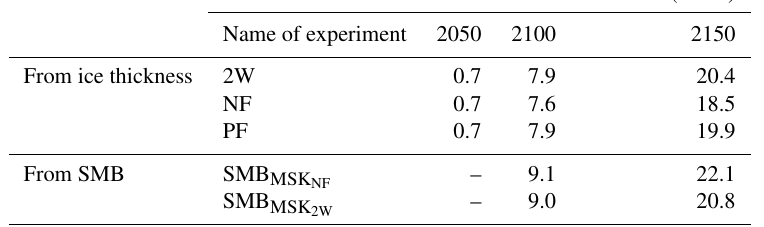
Table 1. Greenland ice sheet contribution (in cm) computed from ice thickness variations simulated with the 2W, NF and PF experiments in 2050, 2100 and 2150, relative to 2000 (first three lines) and from integrated NF SMB values accumulated over the entire GrIS defined by a ) and by the time-evolving ice sheet mask (SMB MSK ) simulated in the 2W experiment (last two fixed ice sheet mask (SMB MSK NF 2W